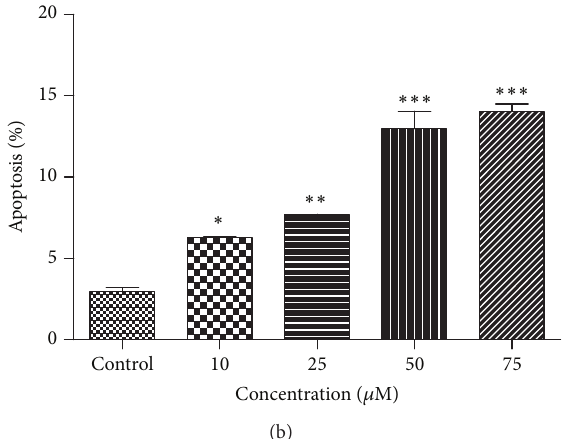
Figure 2: Flow cytometric analysis of quercetin-induced apoptotic cell death in B-CPAP cells. Cells were treated with different concentrations of quercetin (10–75 𝜇 M) for 24 h. Apoptosis was evaluated using Annexin V-FITC and PI staining followed by flow cytometry (a). Cells in the lower left quadrant (Annexin V-FITC − /PI − ) are viable; those in the lower right quadrant (Annexin V-FITC+/PI − ) are early apoptotic and those in the upper right quadrants (Annexin V-FITC+/PI+) are late apoptotic or necrotic. Apoptosis bar graphs (b) represent mean ± SD, 𝑛 = 3 . Differences between means and significance of the treatments were analyzed using ANOVA and Tukey’s multiple comparison test. ∗ 𝑝 < 0.05 versus control, ∗∗ 𝑝 < 0.01 versus control, and ∗∗∗ 𝑝 < 0.001 versus